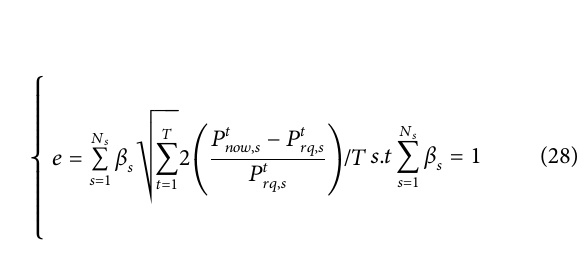
FIGURE 12 | Comparison diagram of electrical output under different uncertainties.